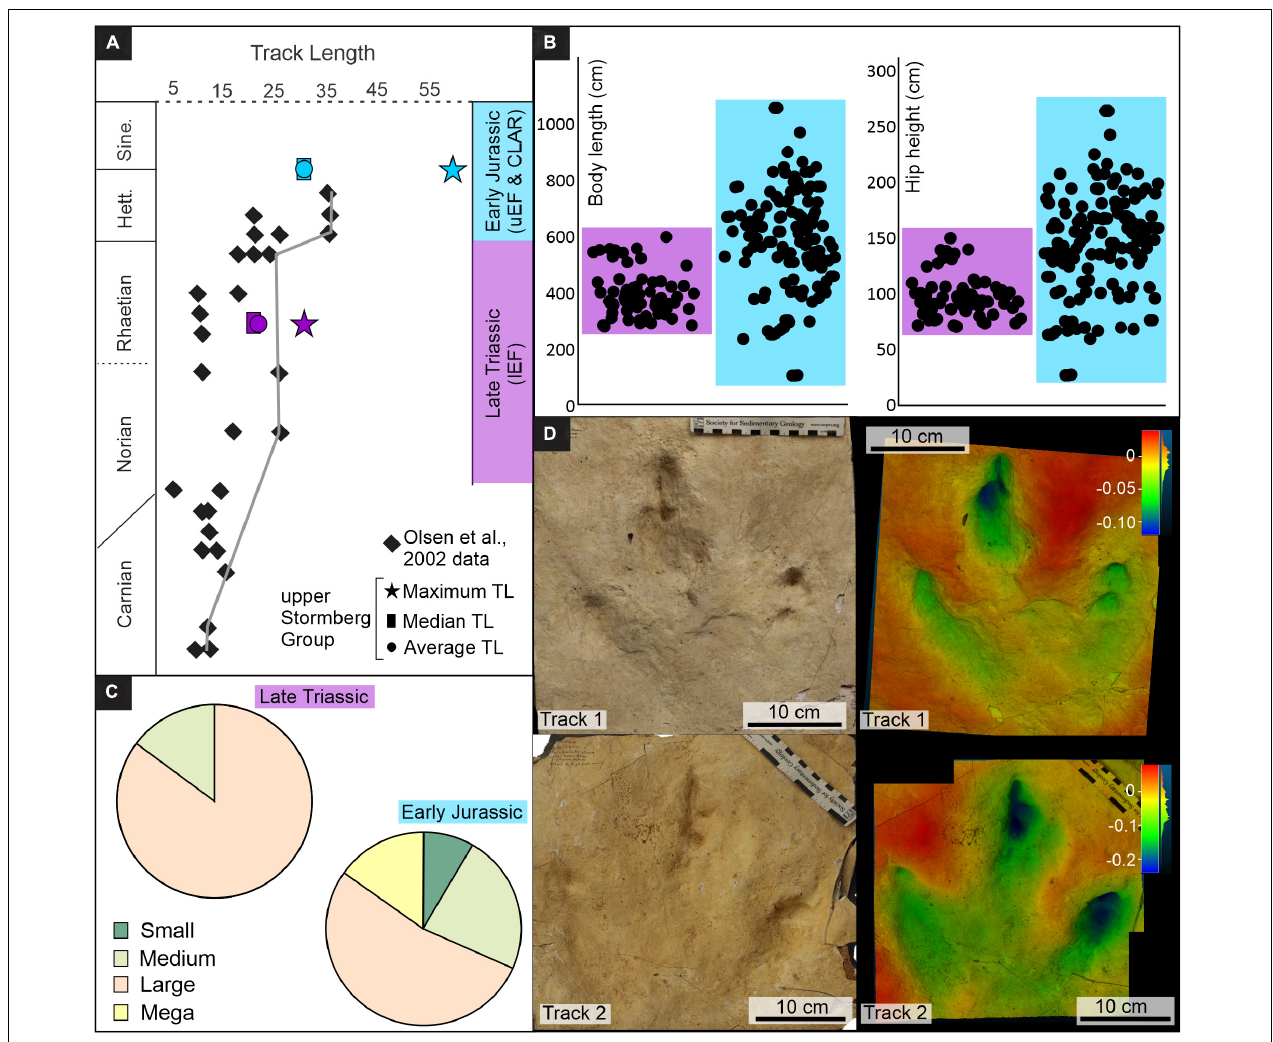
FIGURE 7 | Summary assessment of TLs preserved in the Upper Triassic and Lower Jurassic of southern Africa. (A) Upper Stormberg tridactyl tracks mean and maximum TLs versus those of eastern North America (modified after Olsen et al., 2002), (B) Body length and hip heights (average of morphometric and allometric calculations, Supplementary Table 1 ), (C) Proportion of preserved track size groupings, (D) Photograph and false color depth map of Late Triassic Eubrontes -like lEF tracks from Lower Qeme, Lesotho (the “ Qemetrisauripus princeps” cast materials were made by P. Ellenberger). The tracks have a TL of 27.34 and 30.78 cm, a TL/TW of 1.09 and 1.06, a DP/TS of 0.55 and 0.53, and a DP/TL of 046 and 0.47, respectively. lEF – lower Elliot Formation, uEF – upper Elliot Formation, CLAR – Clarens Formation, TL – track